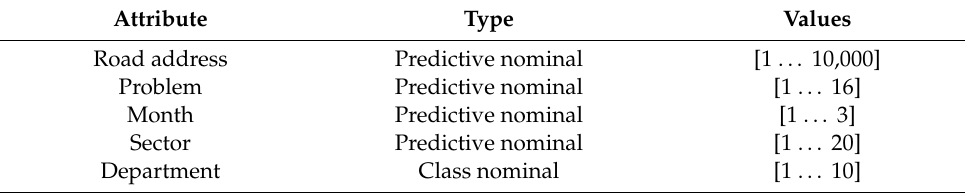
Table 5. Papagos municipality section per season dataset